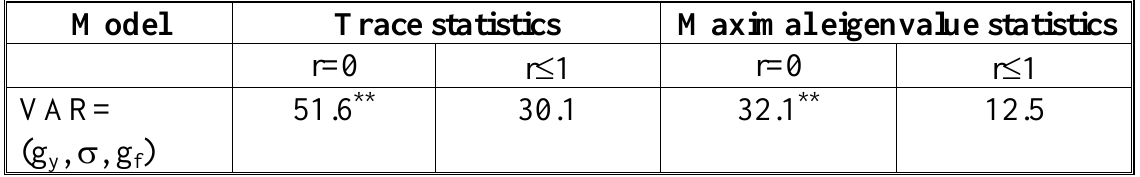
Table 4.5 Johansen cointegration test results (Trace statistics under H :rank=r) o Model Trace statistics Maximal eigenvalue statistics r=0 r ≤ 1 r=0 r ≤ 1 51.6 ** 30.1 32.1 **